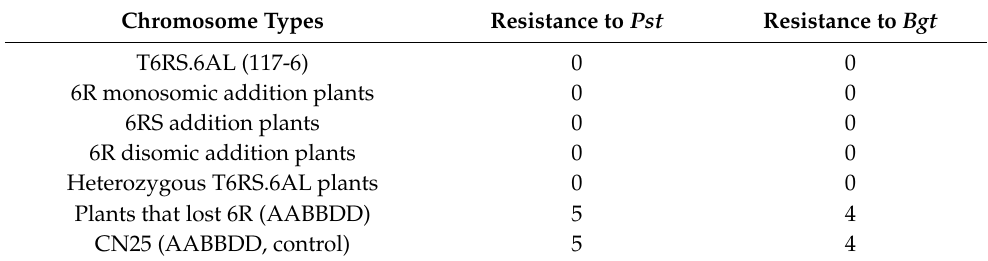
2.3. Agronomic Traits of the T6RS.6AL Translocation Line 117-6 Compared with the wheat parent CN25, the T6RS.6AL translocation line 117-6 showed significantly enhanced agronomic traits (Table 3). In the 2020 to 2021 crop season, no significant differences were observed for plant height (PH), length of spikes (LS), spikelet number per spike (SNPS), kernel number per spike (KNPS), 1000 kernel weight (TKW), and kernel weight per spike (KWPS) between the wheat parent CN25 and the T6RS.6AL translocation line 117-6. However, a significant increase ( p < 0.05) was observed for spike number per plant (SNPP) and kernel weight per plant (KWPP) between them. The SNPP and KWPP of 117-6 were 10.0 ± 1.0 spikes per plant and 33.8 ± 1.2 g per plant, higher